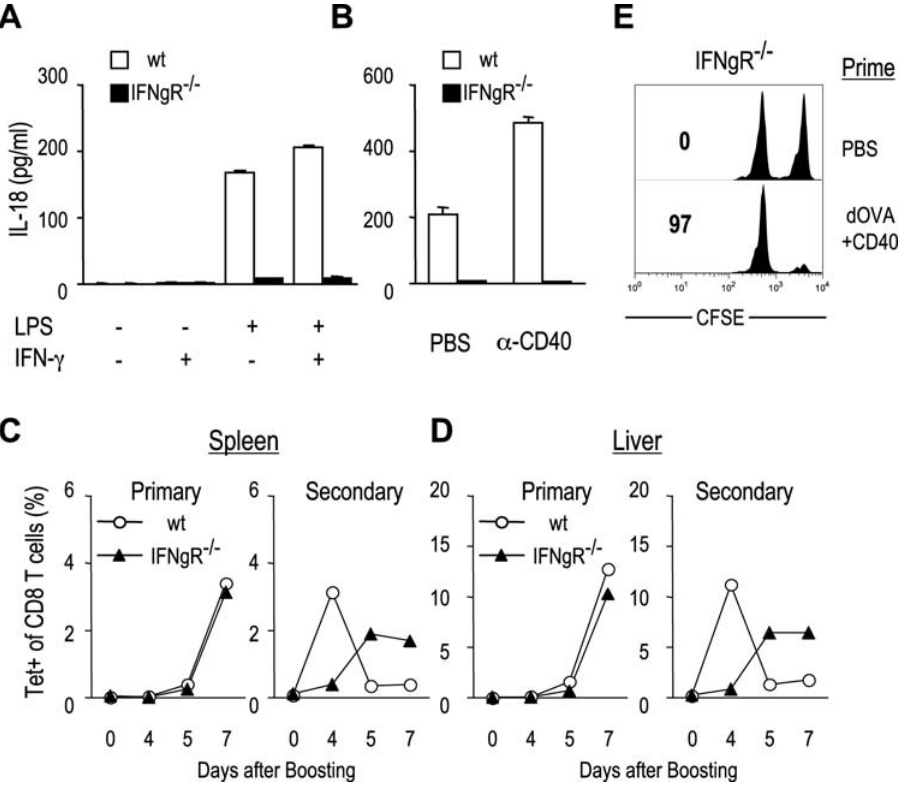
Figure 7. IFN- c signaling regulates the expansion of memory CD8 + T cells. (A, B) IL-18 production from DCs. (A) DCs isolated from spleen of IFN- c R1 2 / 2 and wild type mice were stimulated with LPS in the presence or absence of IFN- c for 24 hr. (B) IFN- c R1 2 / 2 and wild type mice were injected with PBS or anti-CD40 and 1hr later, DCs were isolated and cultured in the presence of LPS for 24 hr. The culture supernatants were harvested and IL-18 production was measured by ELISA. (C, D) IFN- c R1 2 / 2 and wild type mice were primed with PBS or anti-DEC:OVA + anti-CD40, and boosted with anti-DEC:OVA + anti-CD40 at day 60. At day 0, 4, 5, and 7 after boosting, lymphocytes were isolated from spleen (C) and liver (D), and stained with Kb/OVA257-264 tetramer. (C and D)Percentage of tetramer + cells in CD8 + T cells. (E) In vivo CTL activity. IFN- c RI 2 / 2 mice were primed with PBS or anti-DEC:OVA + anti-CD40, without booster immunization. At d 60, CTL activity was determined by challenge with CFSE hi OVA257-264 peptide-loaded splenocytes. Numbers indicate the % of specific killing. Representative of two experiments.